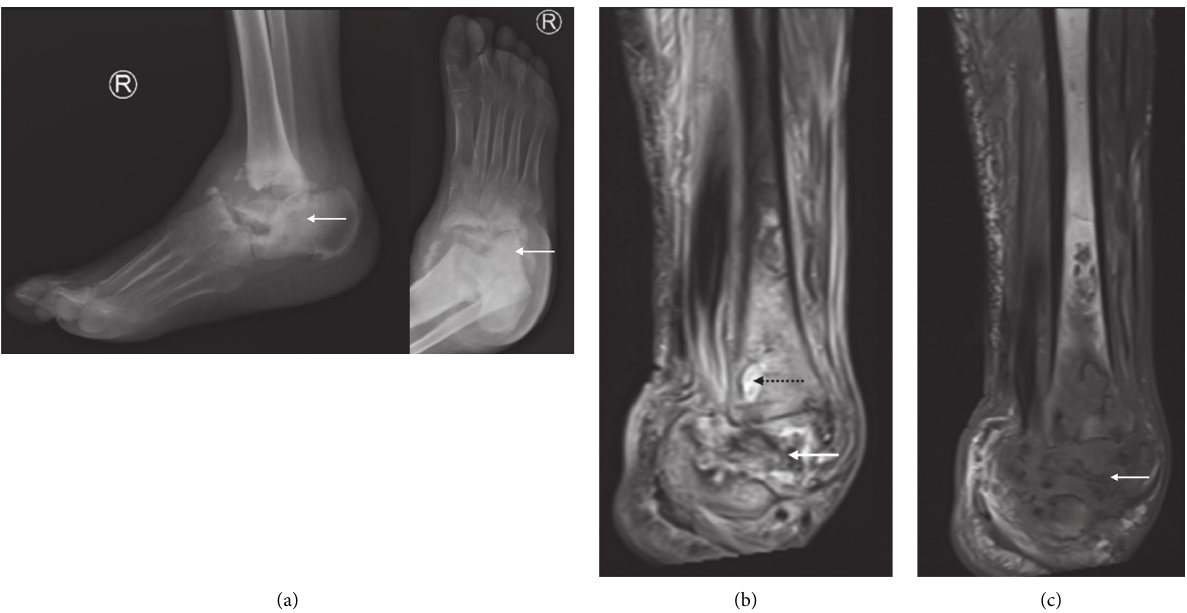
Figure 19: Lateral and oblique right foot radiographs (a) of a 47-year-old woman with type II diabetes and Charcot arthropathy involving the midfoot. Disorganised hindfoot with joint destruction and disorganisation (arrow). Note the absence of osteopenia that is typically observed in infection. Coronal STIR (b) and T1 (c) of a different patient with Charcot arthropathy with hindfoot destruction, hindfoot valgus, and dislocation. The contrast was not administered due to chronic renal failure. The talus is flattened and sclerotic (arrow). Note the fluid collection in the distal tibial shaft (dotted arrow) and the medial tibiotalar articulation. This patient had both neuropathic arthropathy complicated by chronic osteomyelitis with intraosseous abscess formation. At times, different conditions can preexist, and ultimately, tissue sampling may be